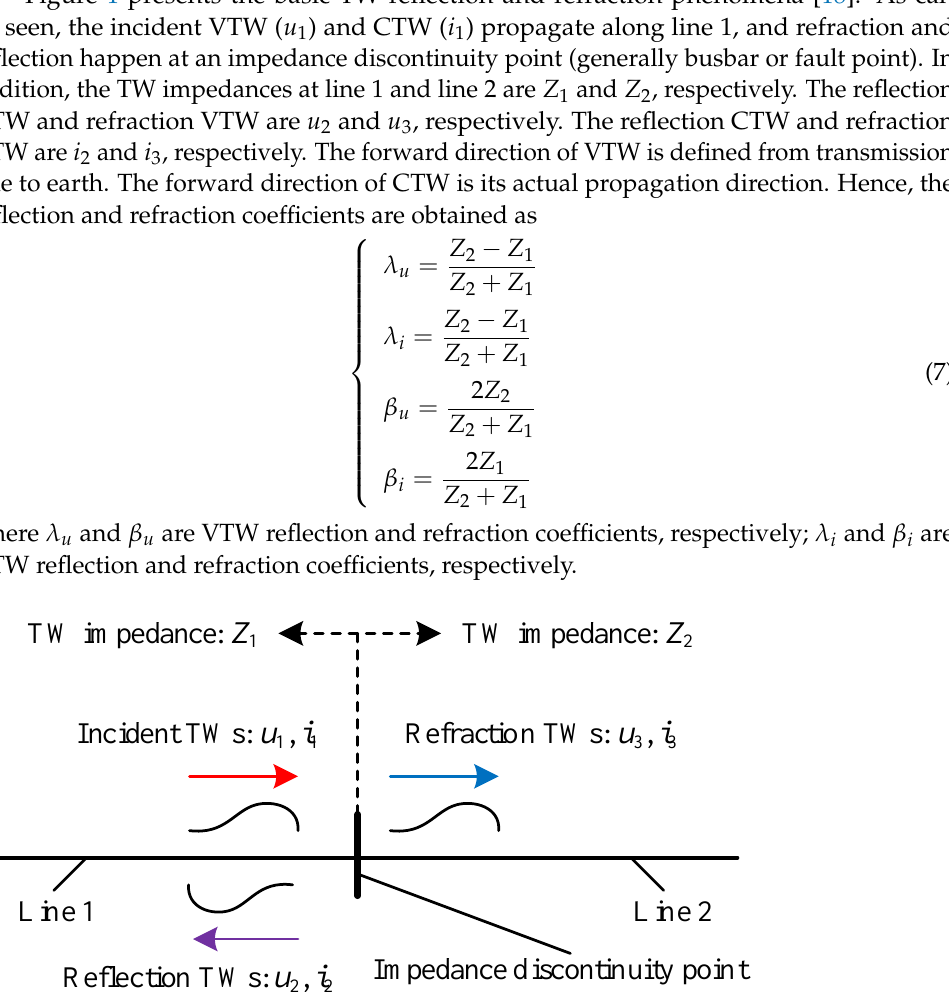
Figure 1. TW reflection and